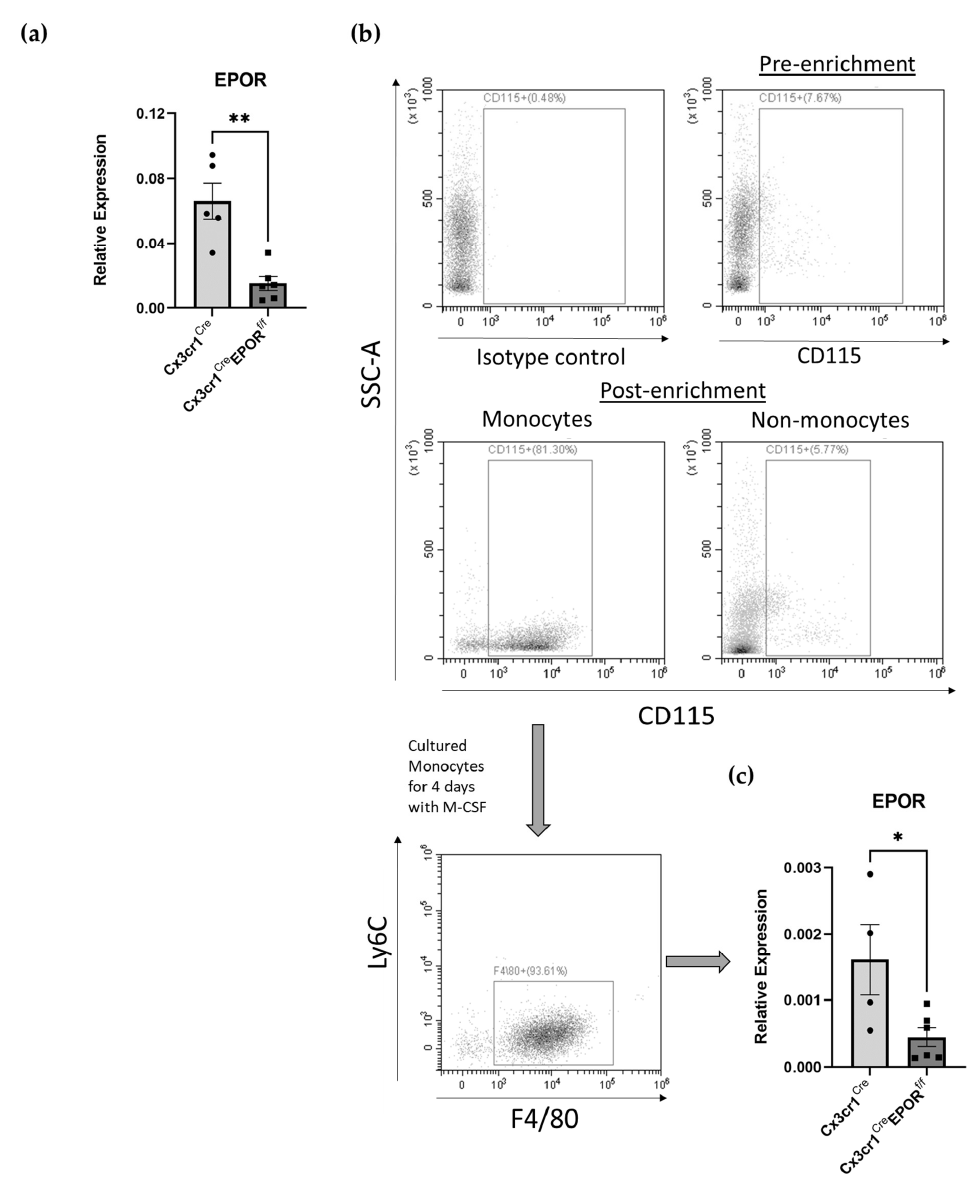
Figure 2. Confirmation of the conditional knockout of EPOR expression in the monocytic lineage in the Cx3cr1 Cre EPOR f/f mice. ( a ) EPOR expression as measured by RT-qPCR in freshly isolated bone-marrow-derived CD115 + cells from Cx3cr1 Cre EPOR f/f mice and their controls. Expression of EPOR was normalized to HPRT. n = 5–6 mice in each group. ** p < 0.01 vs. Cx3cr1 Cre . ( b ) Flow cytometry analysis of freshly isolated BM monocytes after 4 days culture with M-CSF to generate BMDM in vitro. ( c ) EPOR expression as measured by RT-qPCR in BMDM as in ( b ) from Cx3cr1 Cre EPOR f/f mice and their controls. Expression of EPOR was normalized to HPRT. n = 4–6 mice in each group. * p < 0.05 vs. Cx3cr1 Cre . All data are mean ± SEM. p values calculated by a Student’s t -test. 2.3. EPO Erythropoietic Activity Is Preserved in the Cx3cr1 Cre EPOR f/f